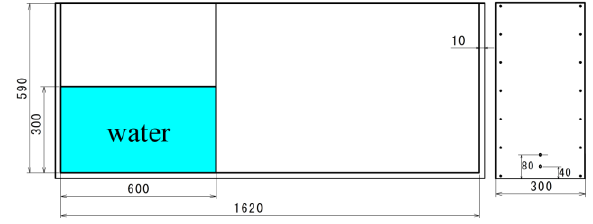
Fig. 3. Dimensions of the dam breaking apparatus .